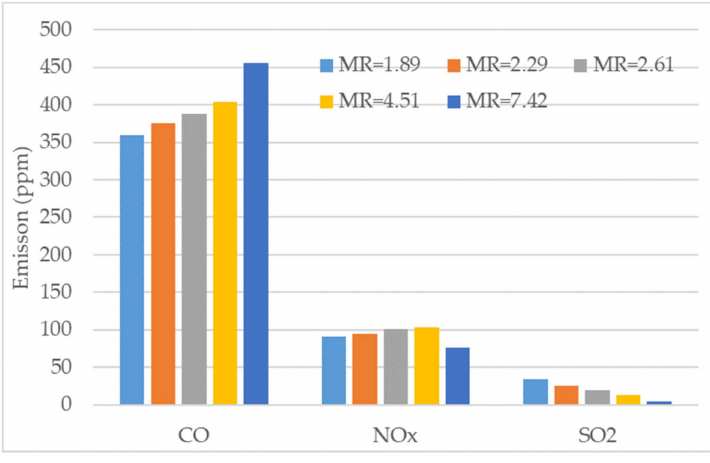
Figure 7. E ff ect of mixing ratio (MR) on CO, NO x , and SO 2